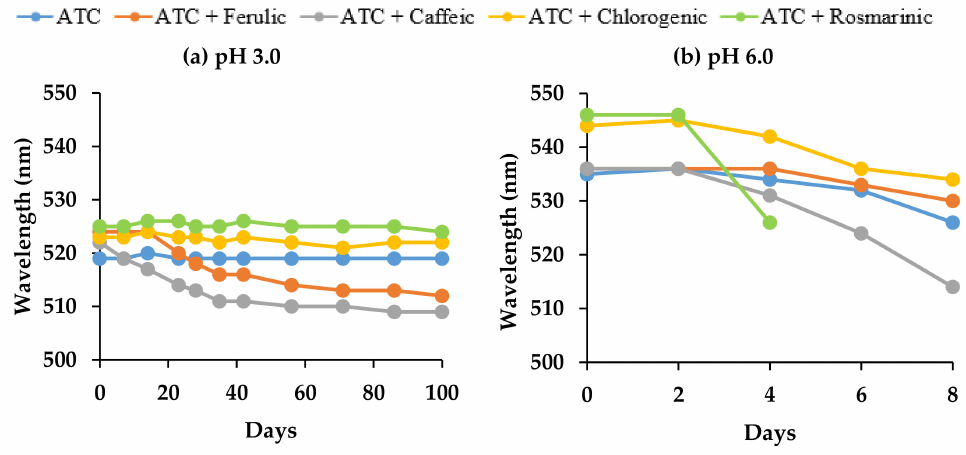
Figure 5. Effect of intermolecular copigmentation on maximum absorption wavelength ( λ max ) (hyperchromic shift) throughout storage in buffer solutions at ( a ) pH 3.0 and ( b ) pH 6.0. *Antho- cyanins